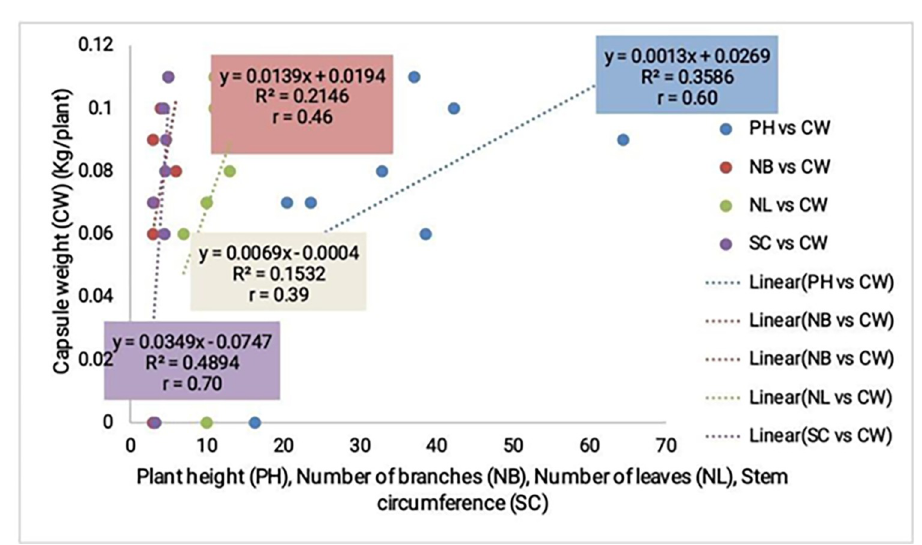
Fig 3. Correlation of vegetative growth parameters with okra yield.